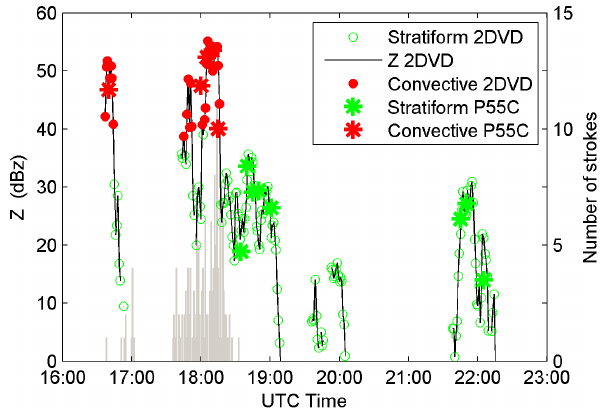
Figure 12. Time series of the reflectivity factors and the number of LINET strokes. Circles represent the reflectivity factor computed from the RSD measured by the 2-DVD, while stars represent the values measured by the Polar 55C radar over the Sapienza site. Green markers indicate stratiform rain, while the red markers indi- cate convective rain classified with the C/S threshold. Finally, the gray bars are the number of strokes registered in 1min in a circular area of 10km radius centered at the Sapienza site (2-DVD